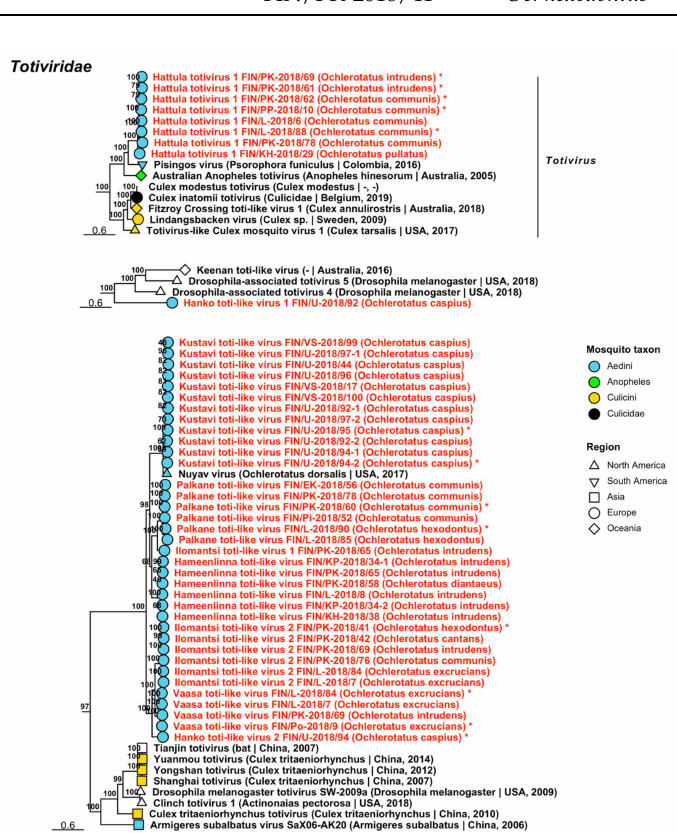
Figure 21. Maximum likelihood subtrees of Totiviridae . Tentative novel viruses are displayed in red and the mosquito species from which they were derived are in parentheses. Sequences from GenBank are black and display the following information after the virus or species name: “(sampled organism(s)|collection country, collection year)”. Tip colours represent the tribe (Culicinae) or genus (Anophelinae) of mosquito from which viruses were obtained. Tip shape represents the continent or region from which the specimens were collected. Trees were constructed from amino acid sequences of virus polymerases >1000 nt, aligned with MAFFT and computed with IQ-TREE2 using ModelFinder and 1000 bootstraps. Asterisks denote that the complete genome was